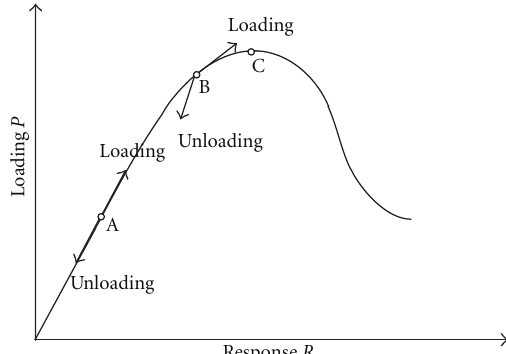
Figure 1: Constitutive relation of